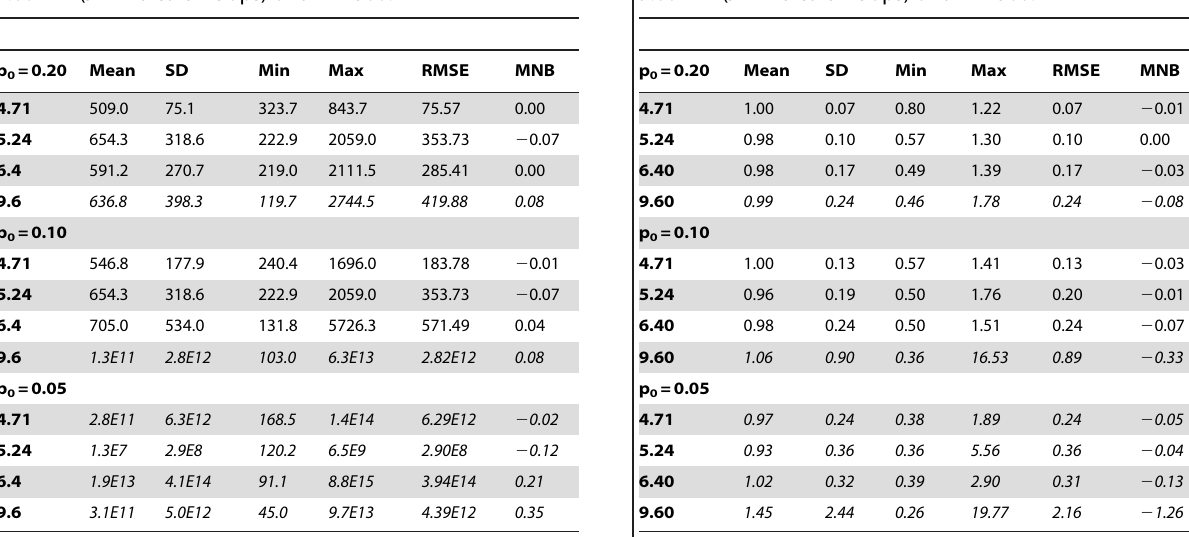
Table 5. For s =1 km, summary estimates of ^ NN in the regular trap configuration when trap spacing increased from 4.71 to 9.60 km (J= 128 to 32 traps) and N=500.